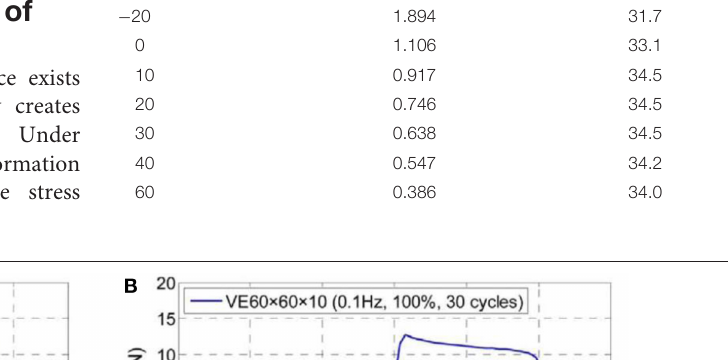
Frontiers in Materials |